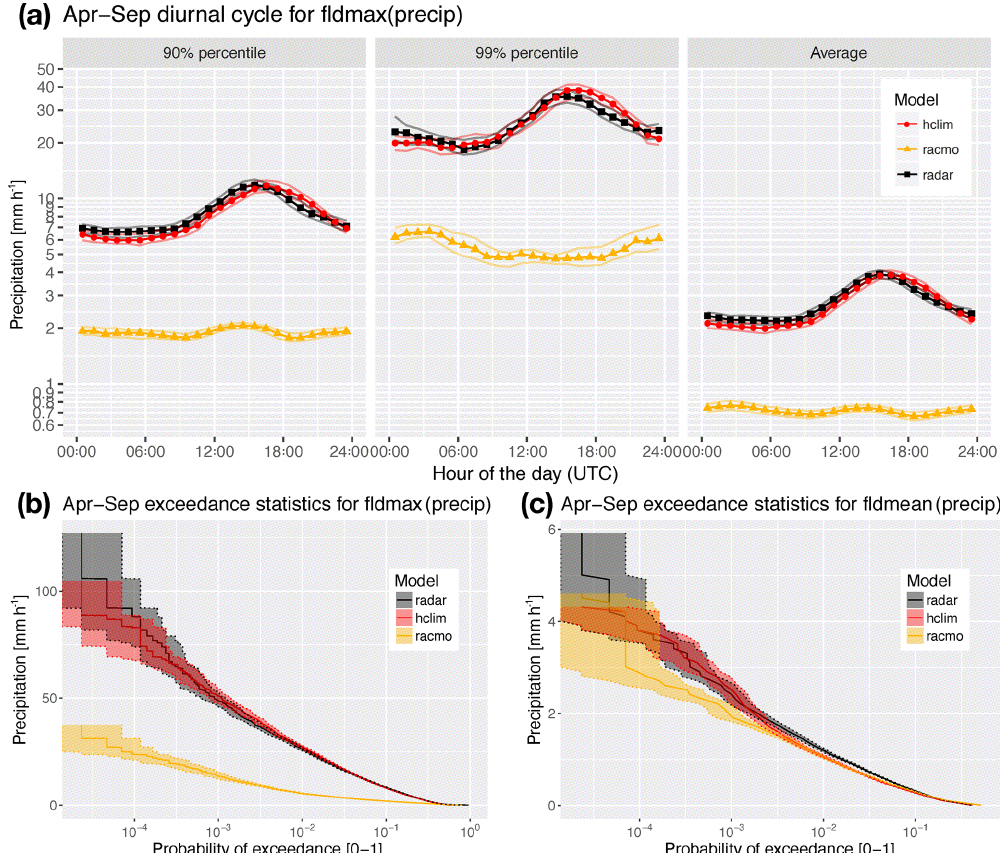
Figure 5. (a) Diurnal cycle of two high percentiles (90th and 99th percentile) and the average of the FLDMAX hourly precipitation distri- bution (April–September) for radar, CPRCM and driving RCM. Probability of exceedance (April–September) for (b) the FLDMAX precipi- tation and (c) the FLDMEAN precipitation (note the difference in the vertical scale). Confidence levels (95%) obtained using bootstrapping are indicated by